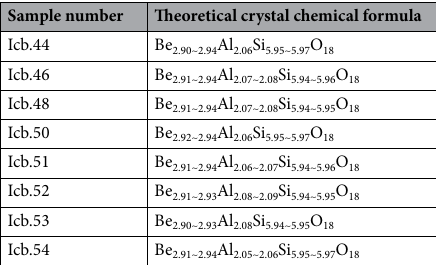
Table 1. The crystal chemical formula of